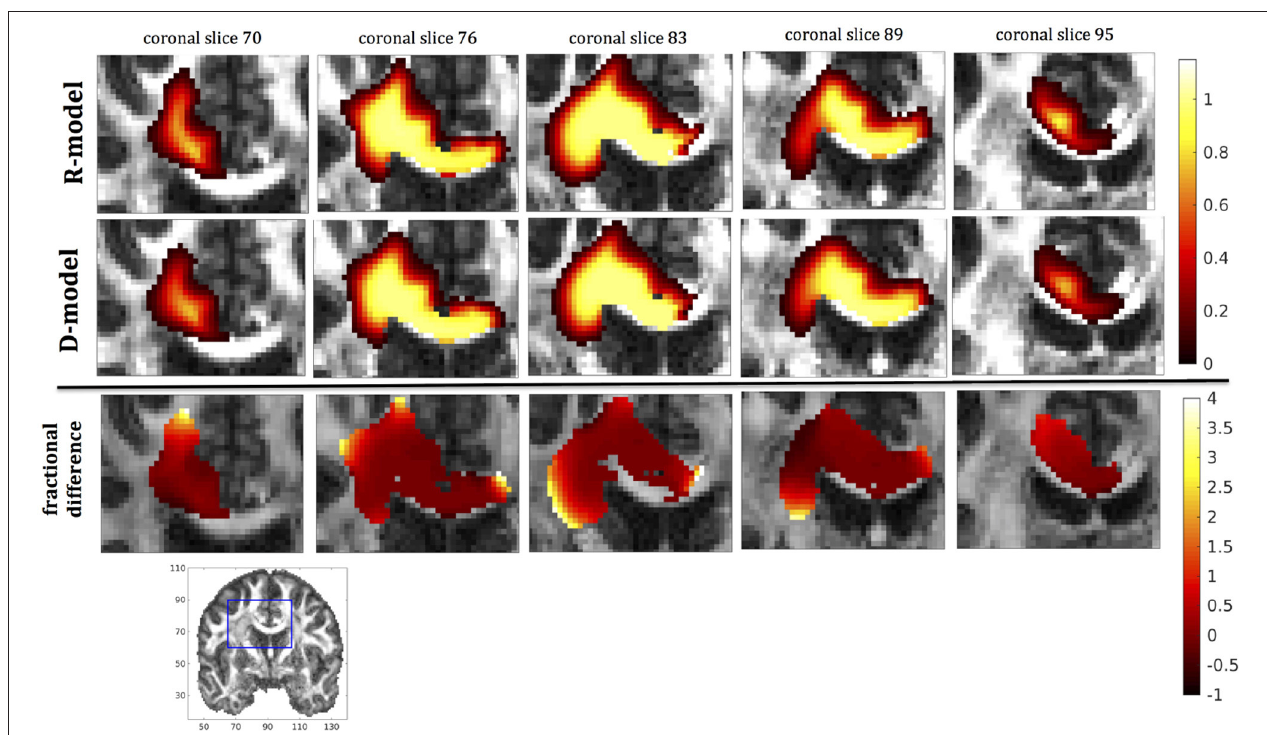
FIGURE 7 | Predicted concentrations for fast infusion in the corpus callosum. (Top) R-model prediction for 5 coronal slices, (Middle) D-model prediction for the same slices, (Bottom) fractional difference in concentrations ( C R − C D C ). The same scale has been used to plot the concentration distributions for the R- and the D- model. D The FA image at the bottom shows in blue the part of the brain slices shown